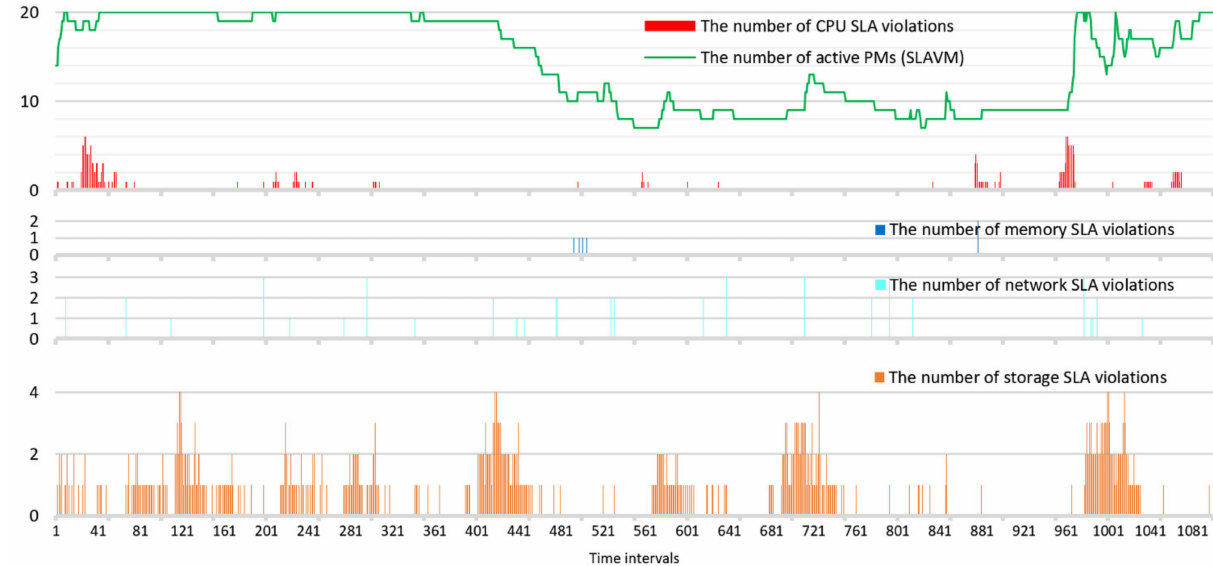
Figure 13. The number of SLA violations during the simulation run using the model parameters L k = 0.1, T k = 0.15, D k = 0.95, and Q k = 0.4.